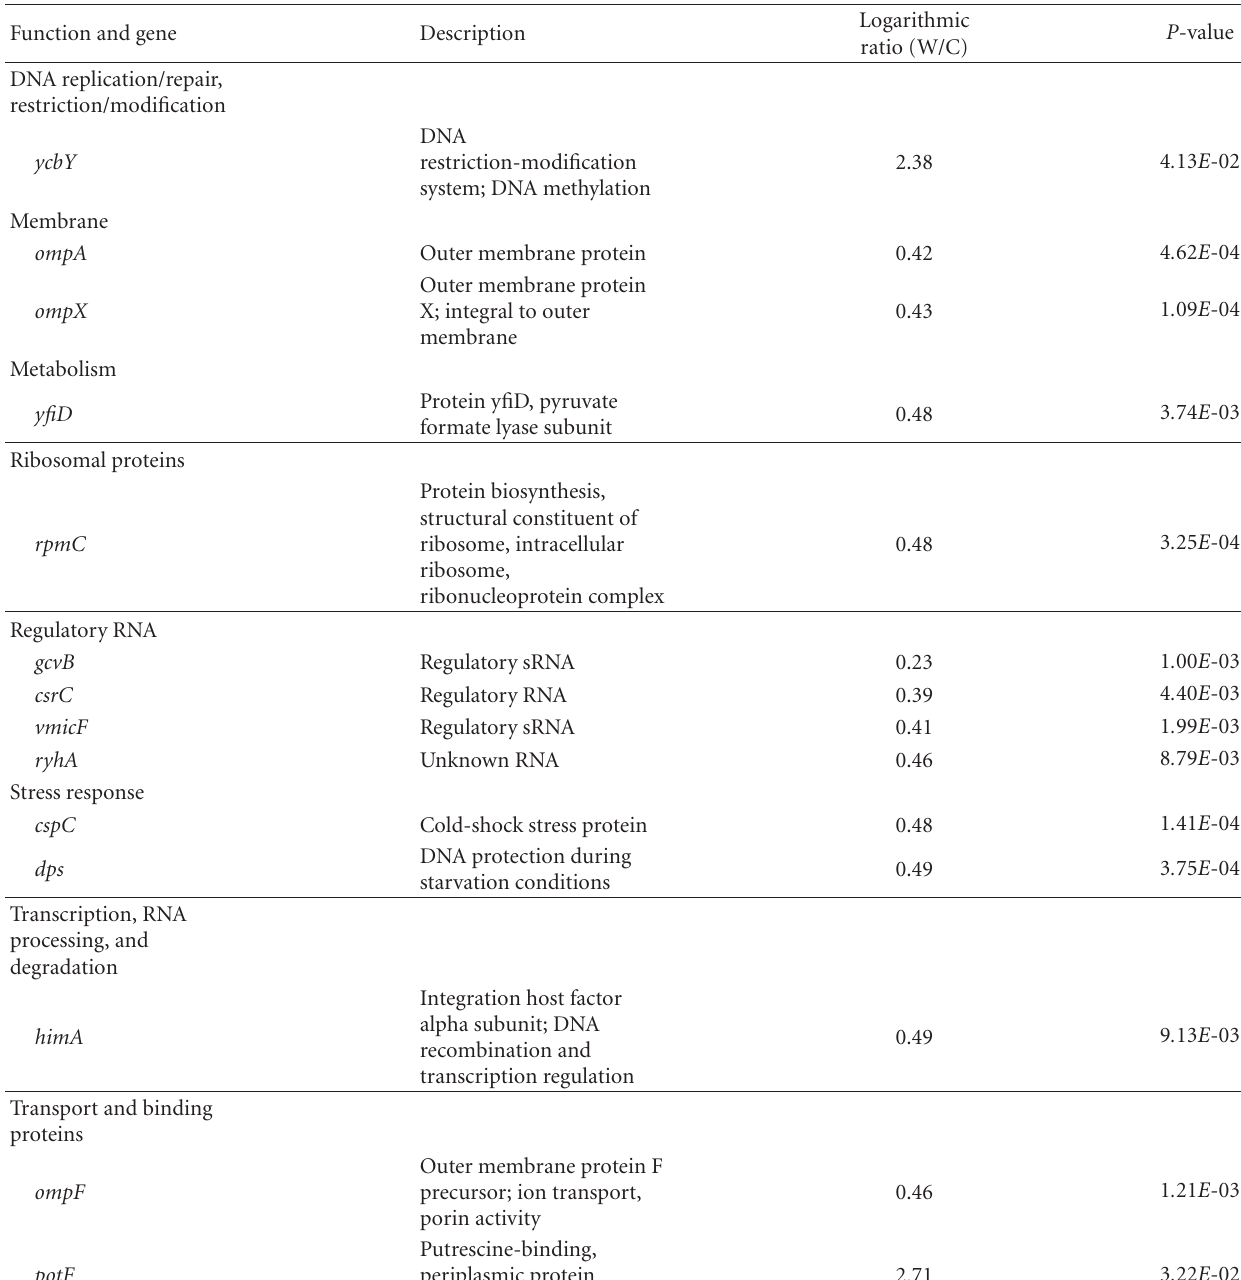
Table 4: Selected genes di ff erentially expressed between growth in LB and sterile water microcosms. Function and